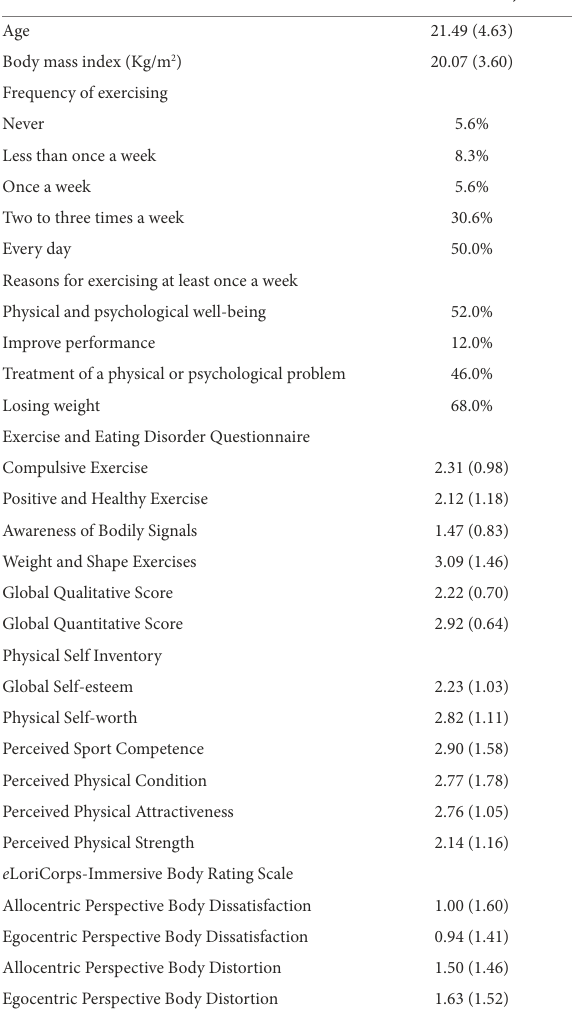
TABLE 1 Descriptive analyses of the sample ( N =